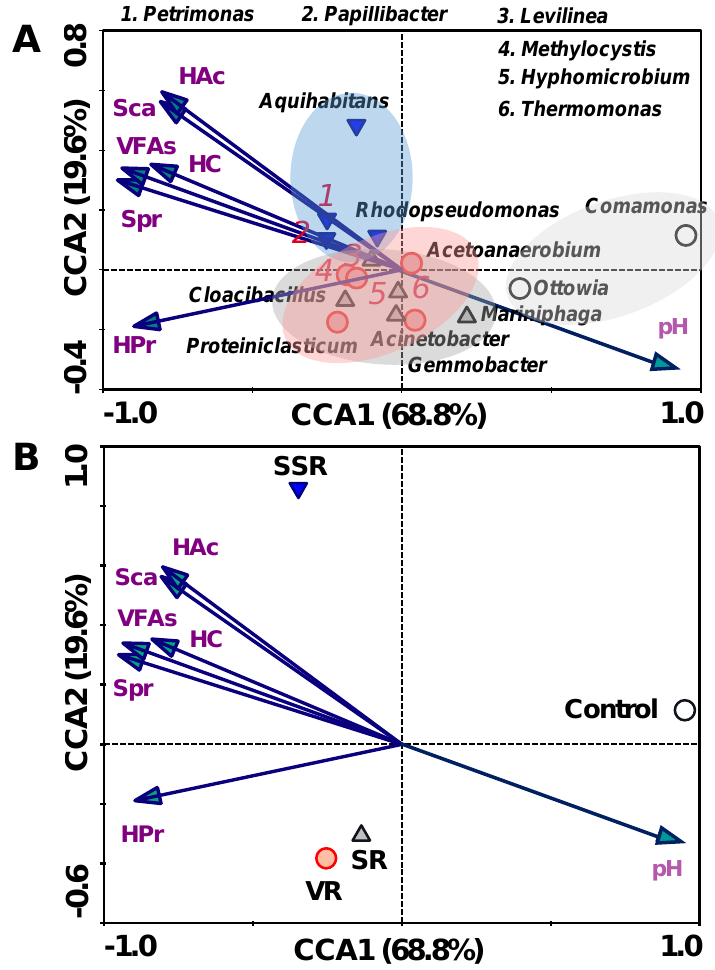
Figure 4. Responses of the functional genus to the environmental variables, canonical correspondence analysis (CCA) based on the enriched genera and environmental variables ( A ), and four samples and environmental variables ( B ). The percentage of variation explained by each axis is shown.